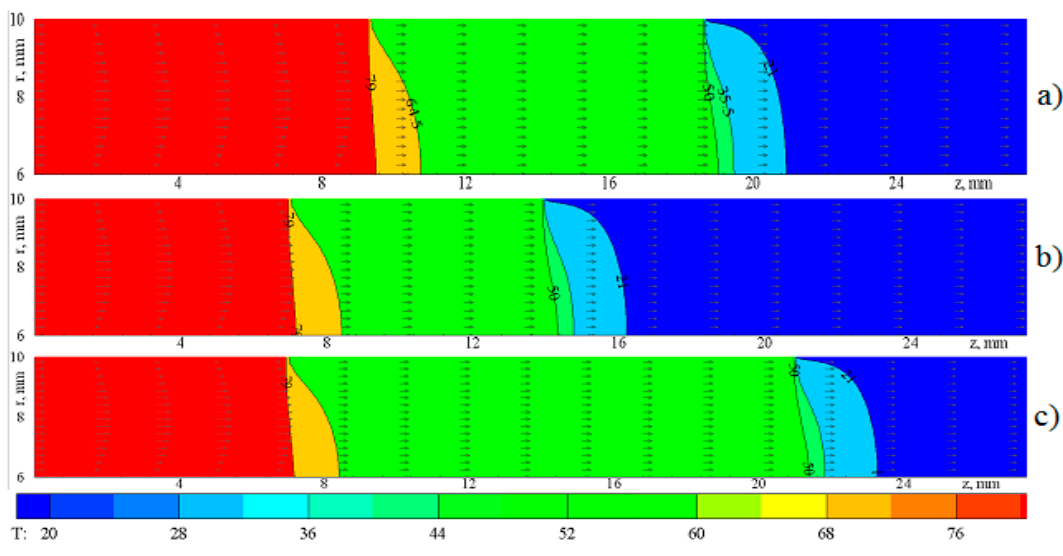
Figure 1. Distributions of the temperature over the annular cavity length at different ratio of the length of the cooling circuits at 𝑈 (cid:2868) = 10 𝑚𝑚/𝑚𝑖𝑛 , ( а ) L 1 = L 3 = 9.4 mm, L 2 = 9.2 mm; ( b ) L 1 = L 2 = 7 mm, L 3 = 14 mm; ( c ) L 1 = L 3 = 7 mm, L 2 = 14